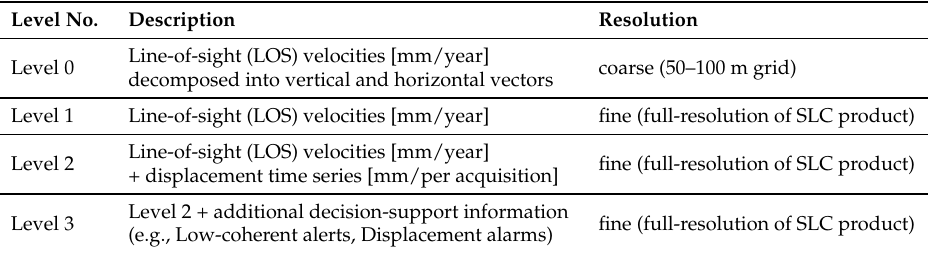
Table 2. Different tiers of product levels as accessible from remotIO’s